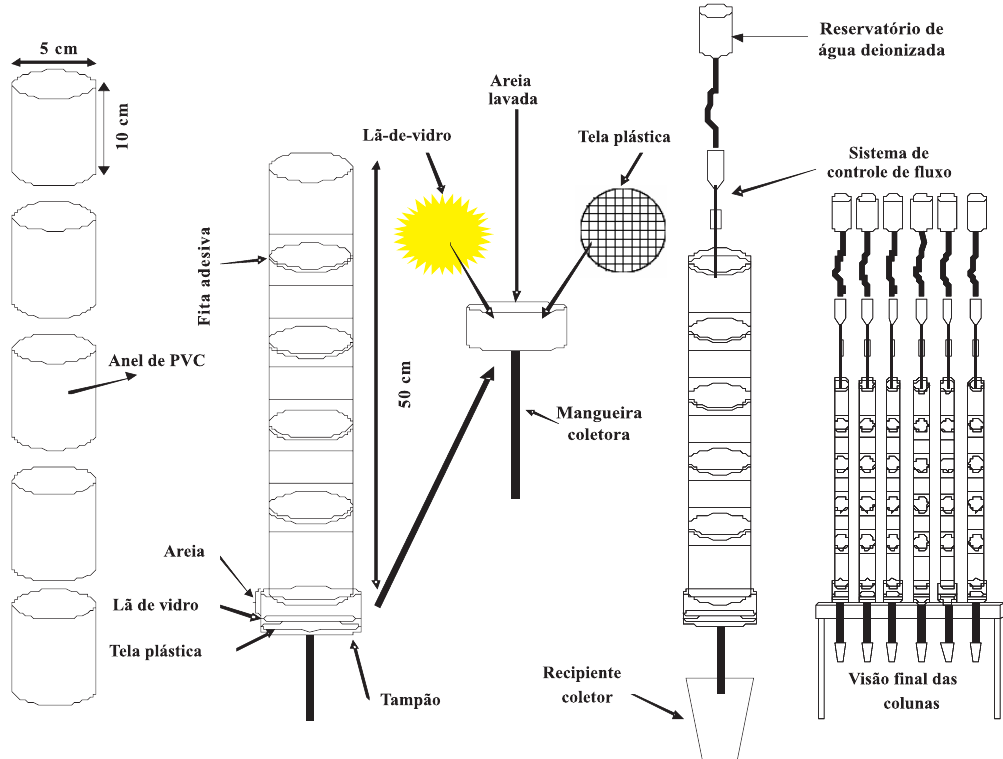
Figura 1. Esquema de montagem das colunas de PVC, para percolação de água, utilizadas no